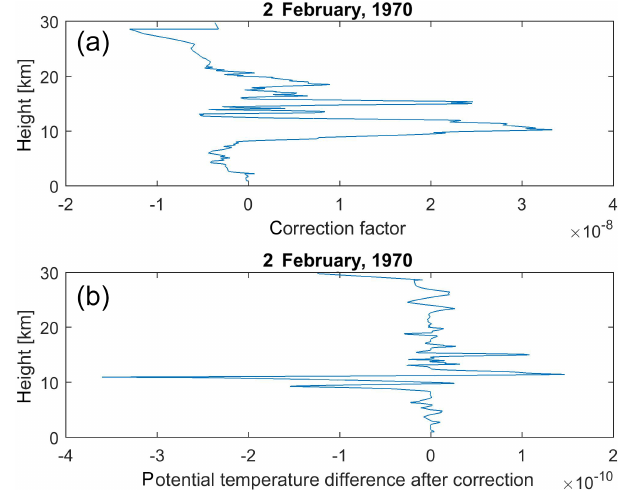
Figure 3. Vertical profile of the potential temperature correction factor (a) and vertical profile of differences between real and smooth potential temperature profiles (b) after correction.